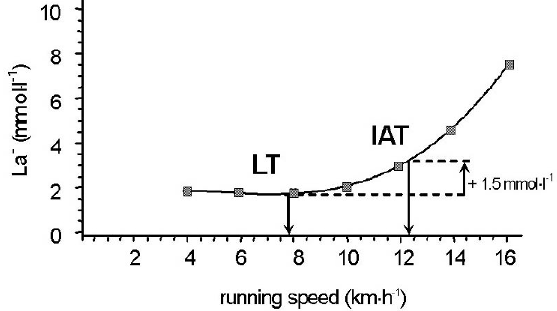
Figure 1. Determination of the aerobic threshold (LT) and the individual anaerobic threshold